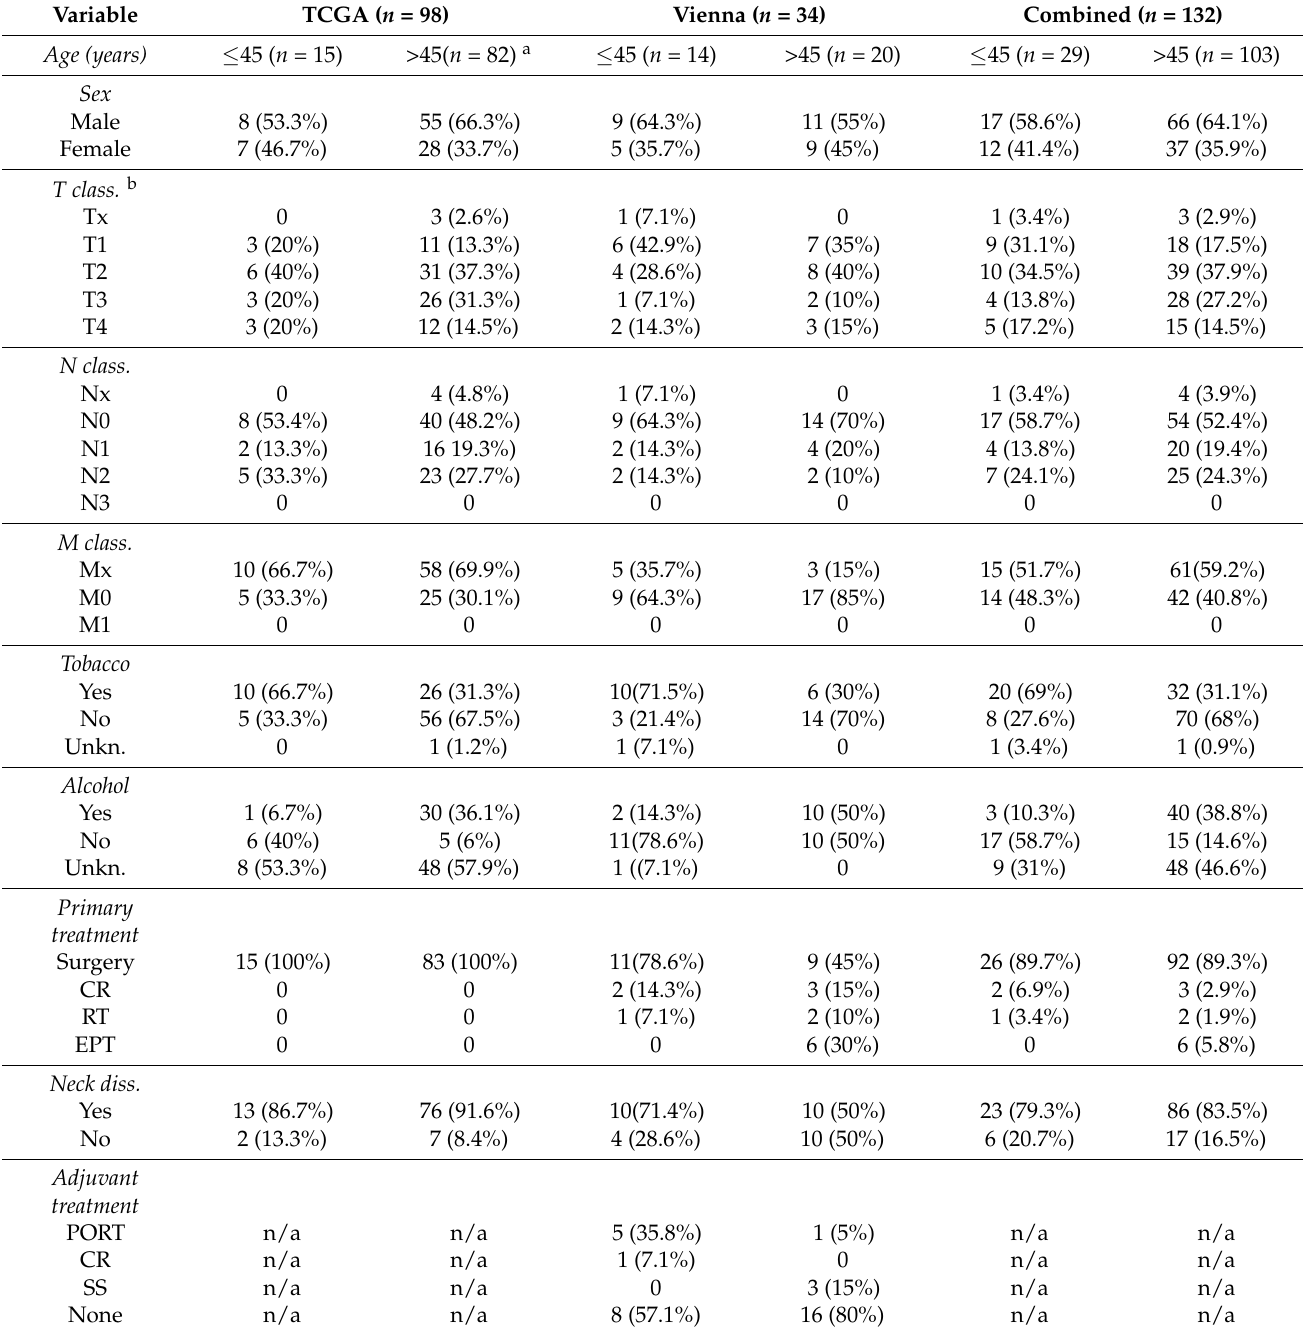
Table 1. Clinicopathologic features of the study samples. Abbreviations: class., classification; unkn., unknown; CR, chemora- diation; RT, radiotherapy; EPT, electroporation therapy; Neck diss., neck dissection; PORT, postoperative radiotherapy; SS, salvage surgery (after